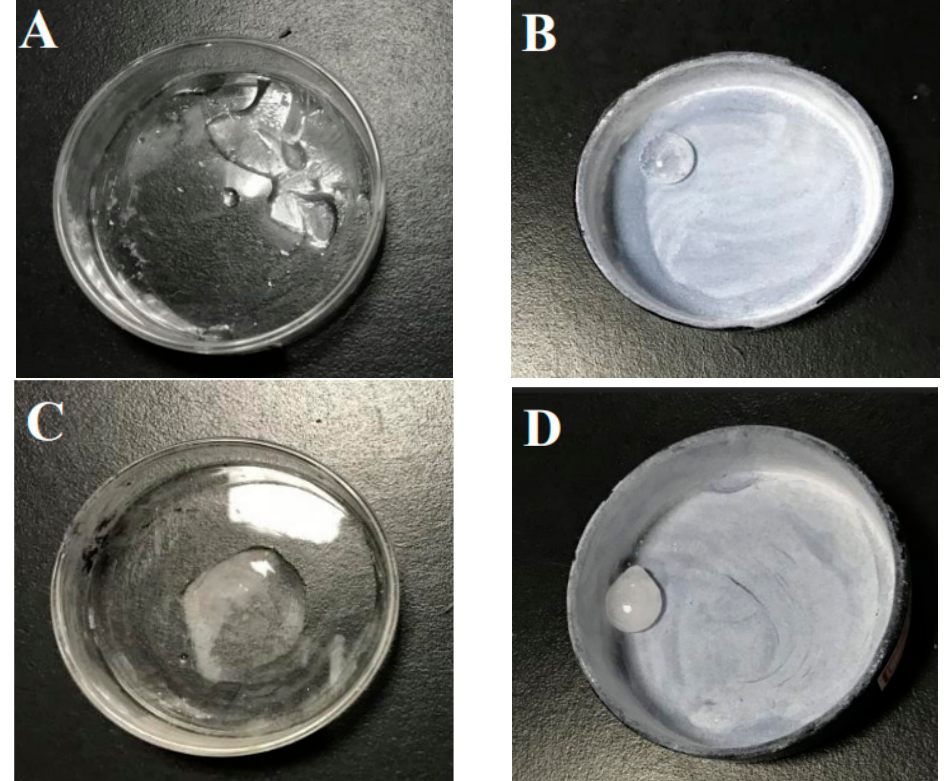
Figure 9. Waterdrop state on the sample surface ( A ) − 2 °C for 25 min, uncoated sample ( B ) − 2 °C for 40 min, coated sample ( C ) − 5 °C for 10 min, uncoated sample ( D ) − 5 °C for 16 min, coated sample.